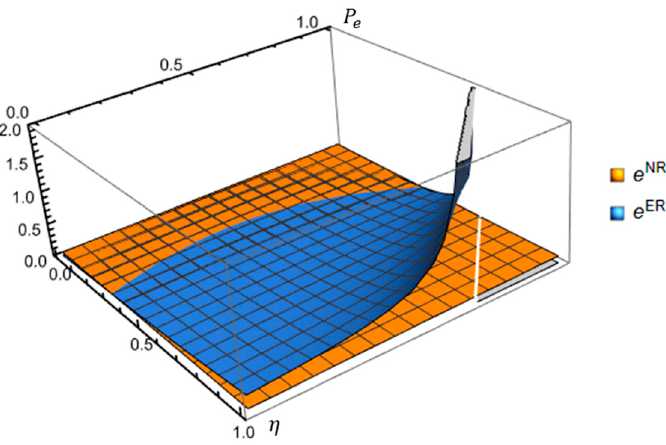
Figure 6. Impact of η and p e on the carbon emission